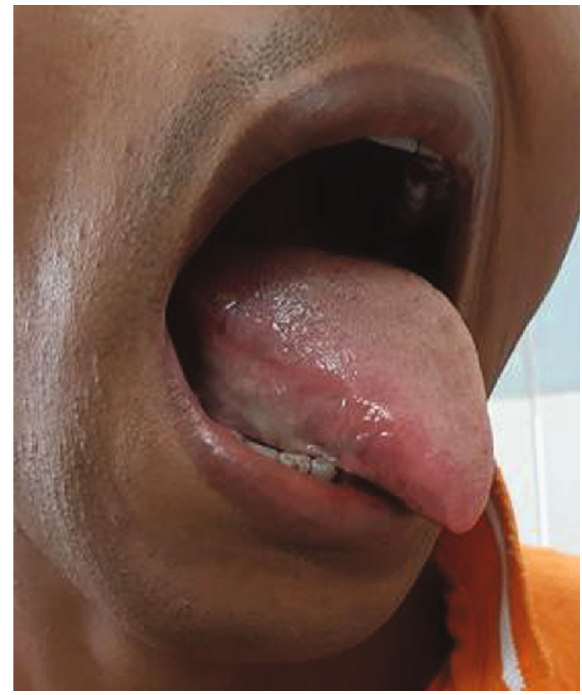
Figure 8: The patient followed up after 1 (one) year, and there was no recurrence of the disease.